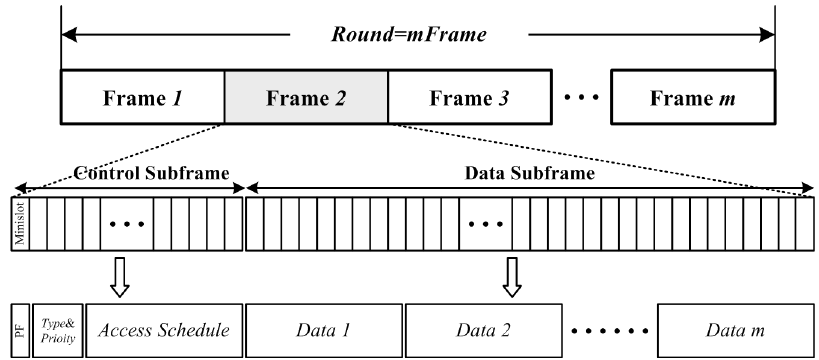
Figure 3. Round structure in adaptive TDMA schedule.